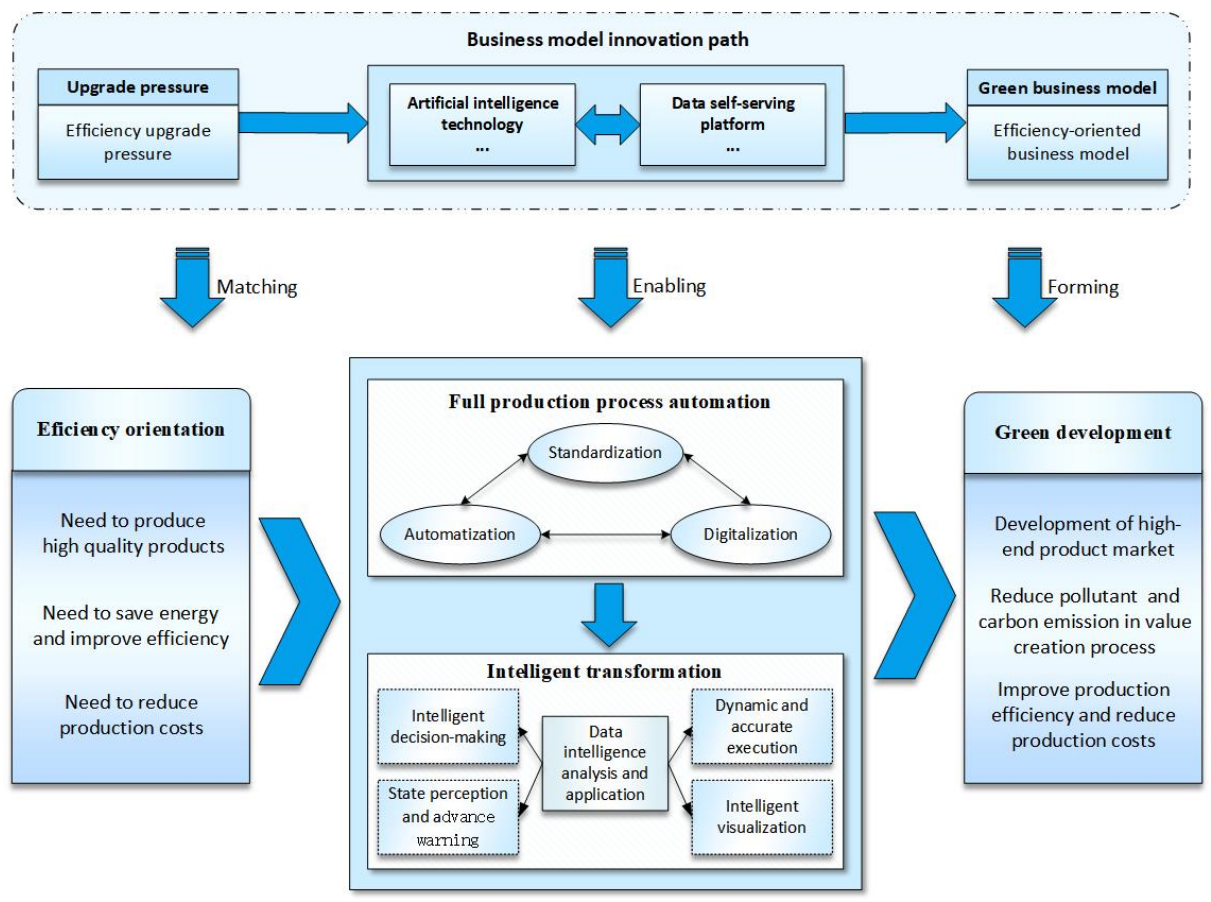
Figure 4. Conceptual model of the efficiency-oriented path.